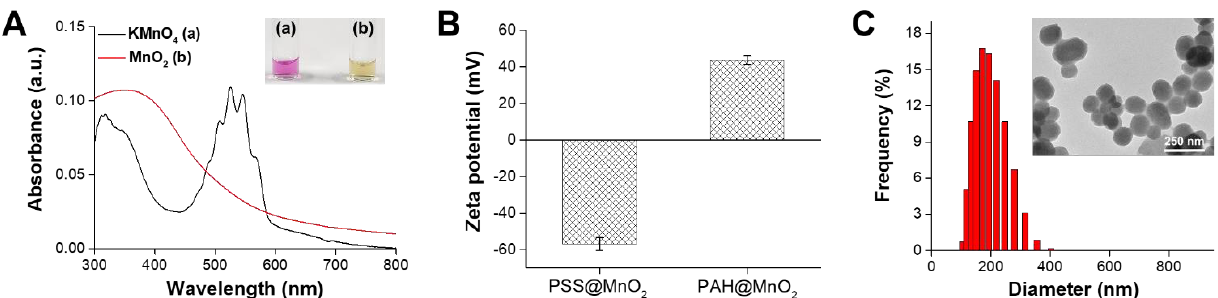
Figure 1. ( A ) UV – vis absorption spectra of KMnO 4 and MnO 2 in DI-H 2 O; the inset is a corresponding digital photo. ( B ) Zeta potential values of PSS@MnO 2 and PAH@MnO 2 ( n = 3). ( C ) Dynamic light scattering (DLS) analysis results of PAH@MnO 2 NPs; the inset shows the corresponding TEM.